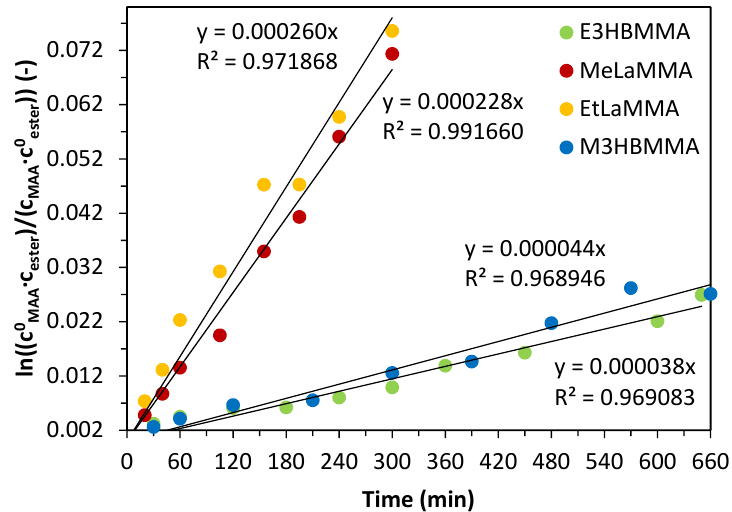
Figure 7. The graphic solution of second-order reaction rate of methacrylation reaction of alkyl es- ters. Table 5. The calculated values of reaction rate constants ( k ′ ) for methacrylation of alkyl esters of